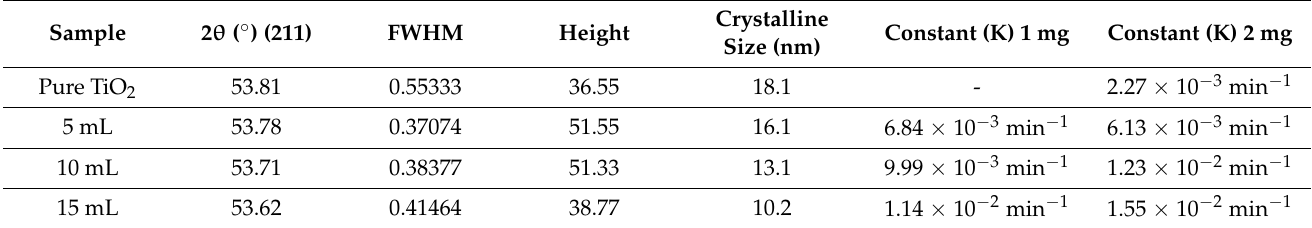
Table 1. Structural properties of bulk TiO 2 i-e hydrothermally treated and altered with 5, 10, and 15 mL of FC leaf